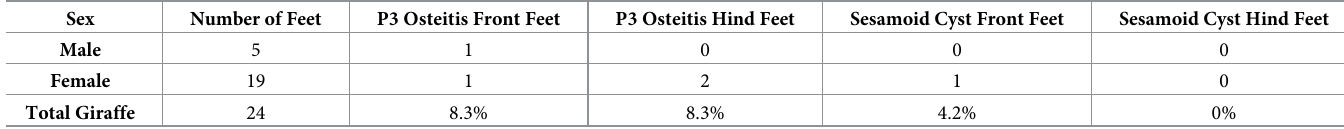
Table 2. Foot radiographs demonstrate that P3 osteitis and distal sesamoid cysts were uncommon in both male and female free-ranging giraffe. Sex